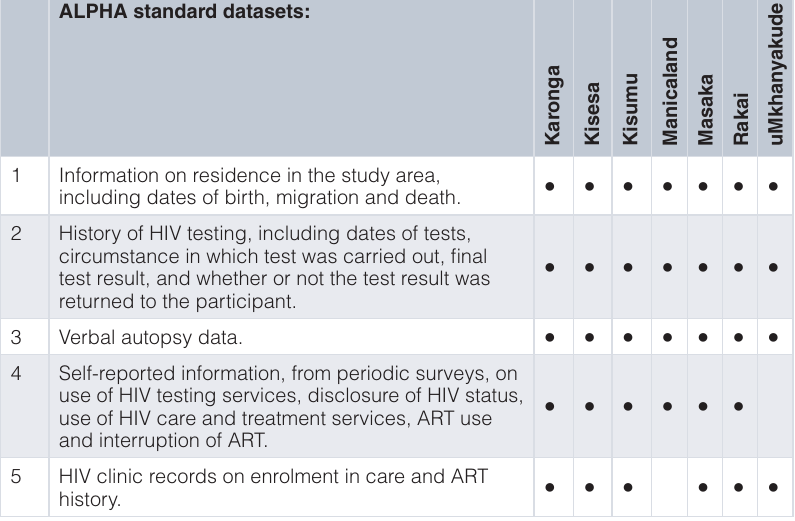
Table 1. ALPHA standard datasets available from each site. ALPHA standard